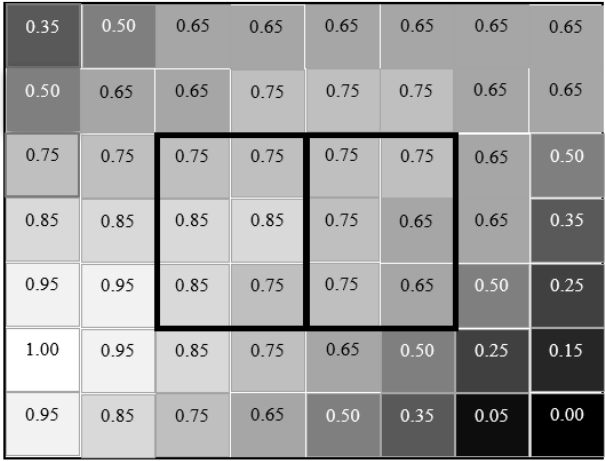
Figure 4. Schematic of pixels shading scores and two panels.